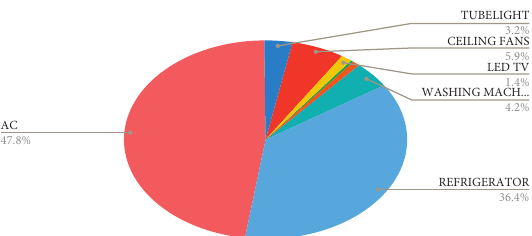
Figure 4: Load distribution—conventional Table 2: Load calculation—improved appliances—1BHK.